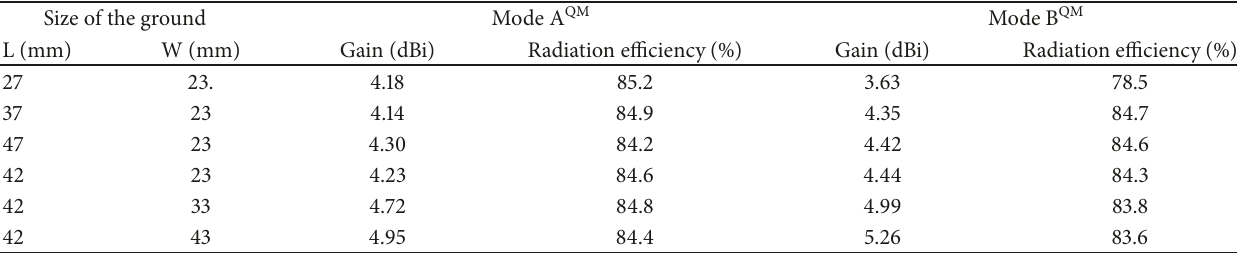
Table 2: Effect of ground size on radiation performance of